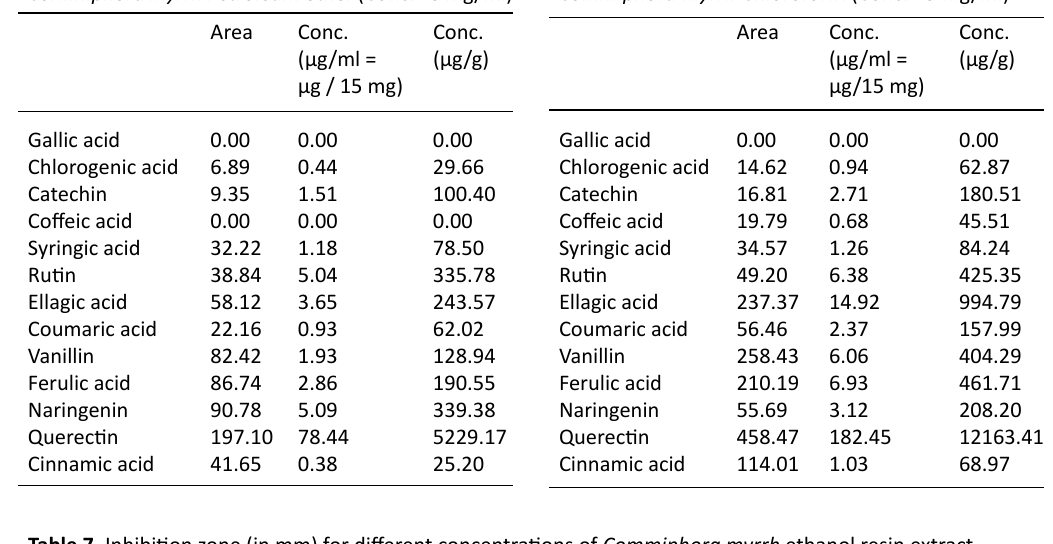
Table 7. Inhibition zone (in mm) for different concentrations of Commiphora myrrh ethanol resin extract Microorganism Concentration of the of Mean Commiphora myrrh ethanol Microorganism resin extract